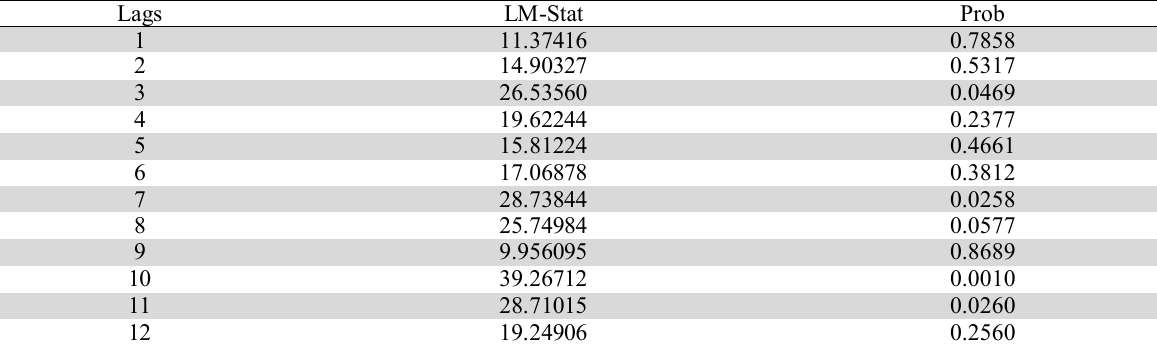
The summary of testing autocorrelation